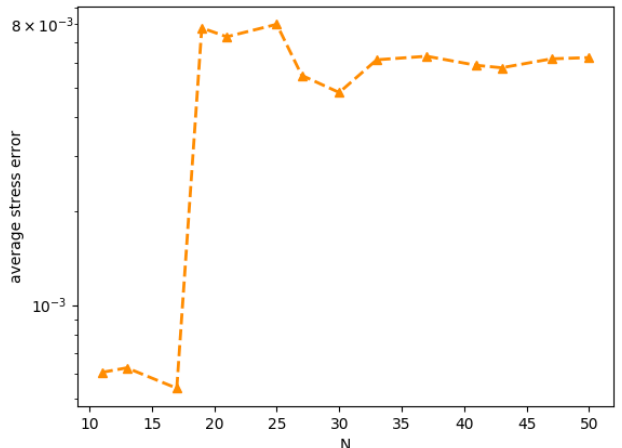
Figure 13. Average approximation error for the solid stress at the FSI